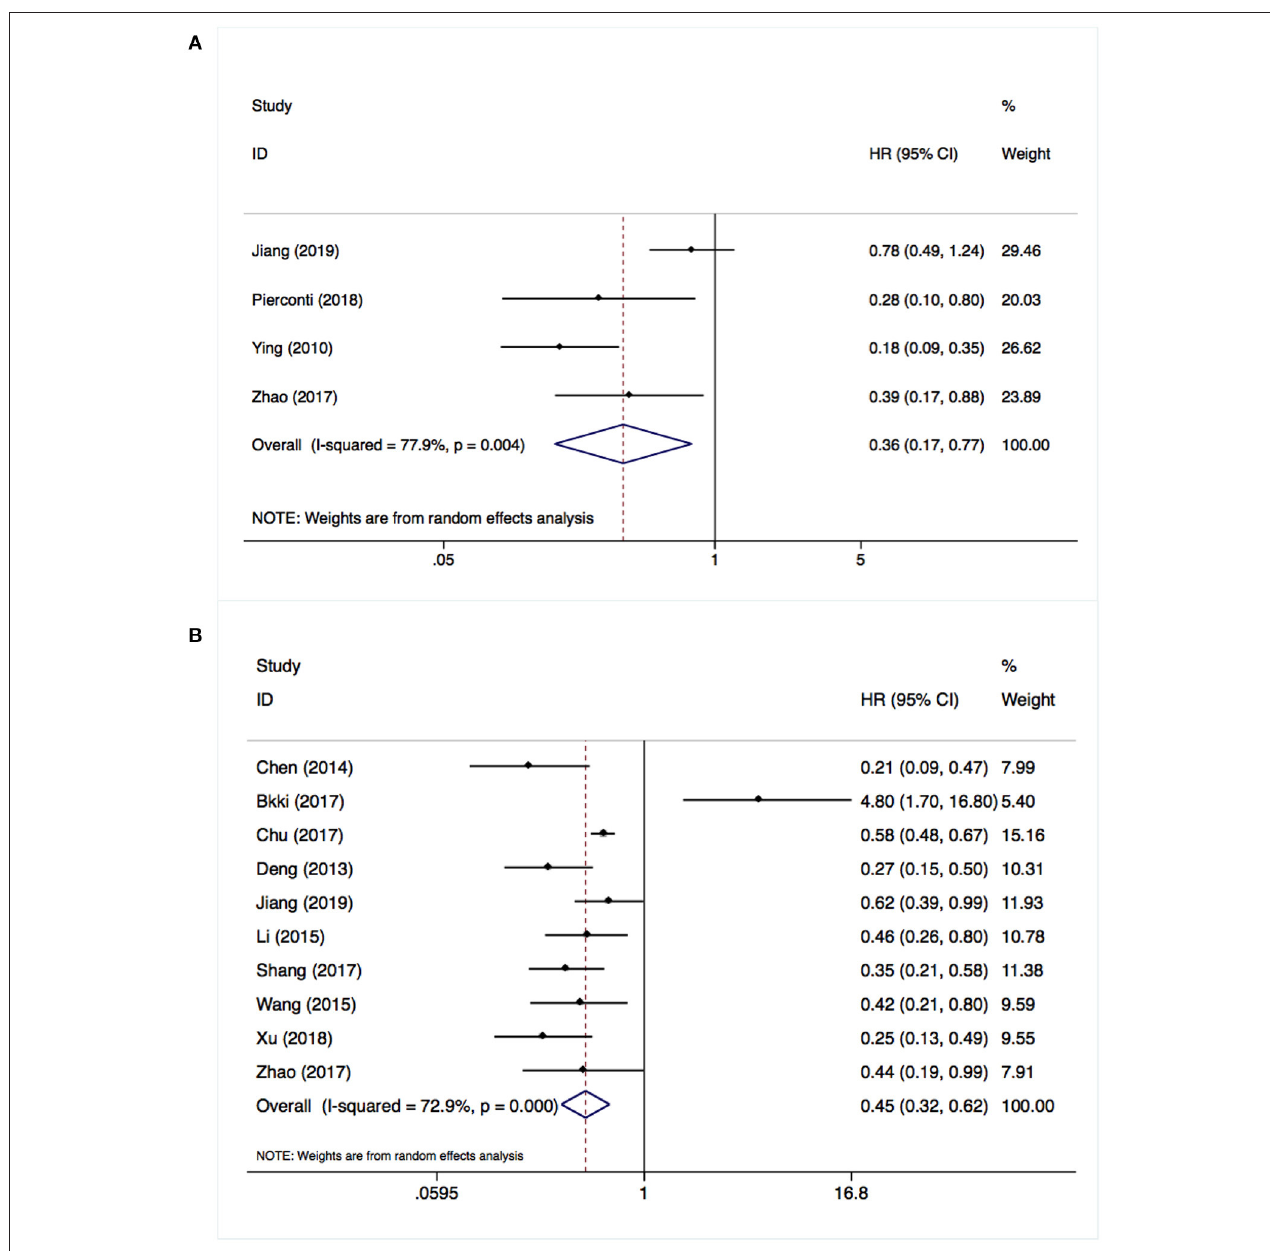
FIGURE 2 | Overexpressed suppressor of cytokine signaling 3 (SOCS3) was associated with better disease-free survival (A) and overall survival (B) . Considering the degree of heterogeneity (I 2 = 77.9%), a random-effects model was utilized for the analysis of these data. We found that an elevated SOCS3 expression in tumor tissues was significantly correlated with better DFS (HR:0.36, 95% CI:0.17–0.77, P < 0.001) vs. low expression ( Figure 2A ). Similarly, a pooled analysis of 10 studies with 1,119 cases using the random-effects model (I 2 = 72.9%) revealed that higher levels of SOCS3 were significantly associated with better OS vs. low levels (HR:0.45, 95% CI:0.32–0.62, P < 0.001) ( Figure 2B , Table 2 ).